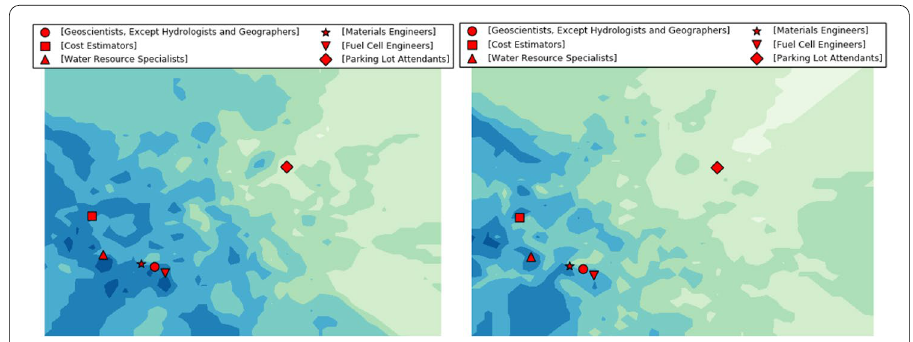
Fig. 9 LDA Heatmap for GCC (left) and USA (right) oil &